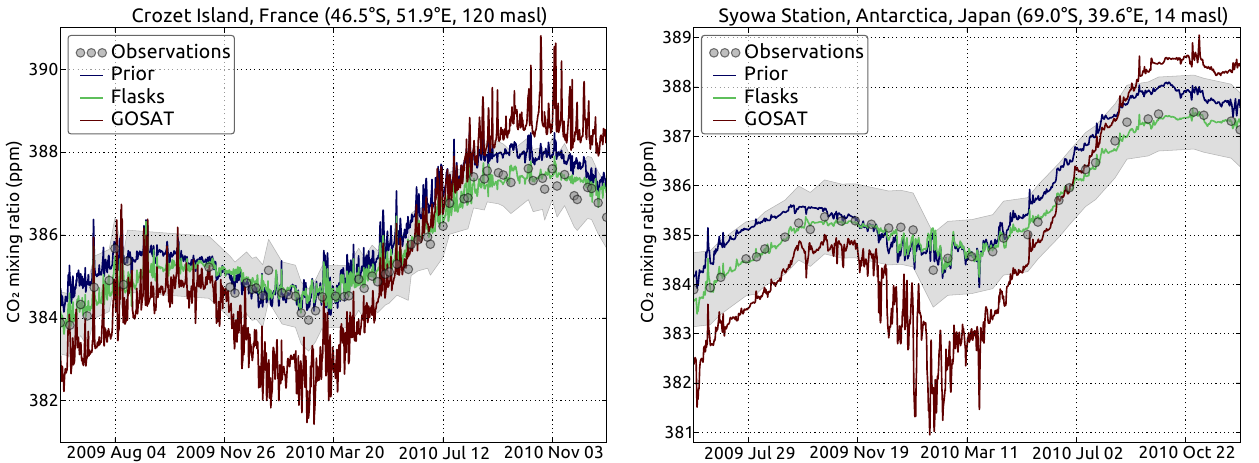
Fig. 4. Model estimated CO 2 time series at two surface stations in the southern extra-tropics, compared to CO 2 measurements taken at those stations. The “GOSAT” line is from an inversion using only GOSAT X CO